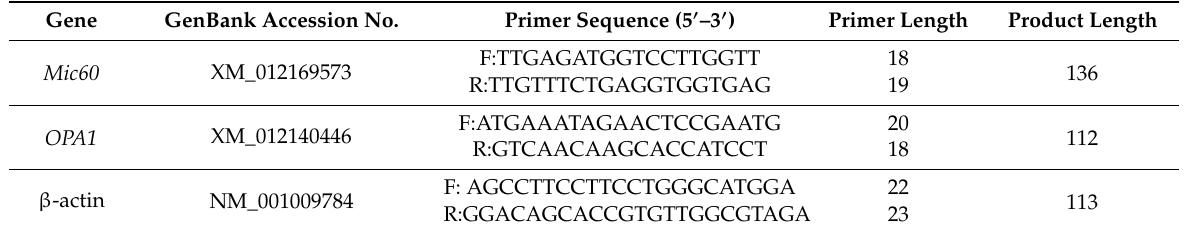
Table 1. Primer information for Tibetan sheep MIC60 , OPA1 and β -actin genes. Gene GenBank Accession